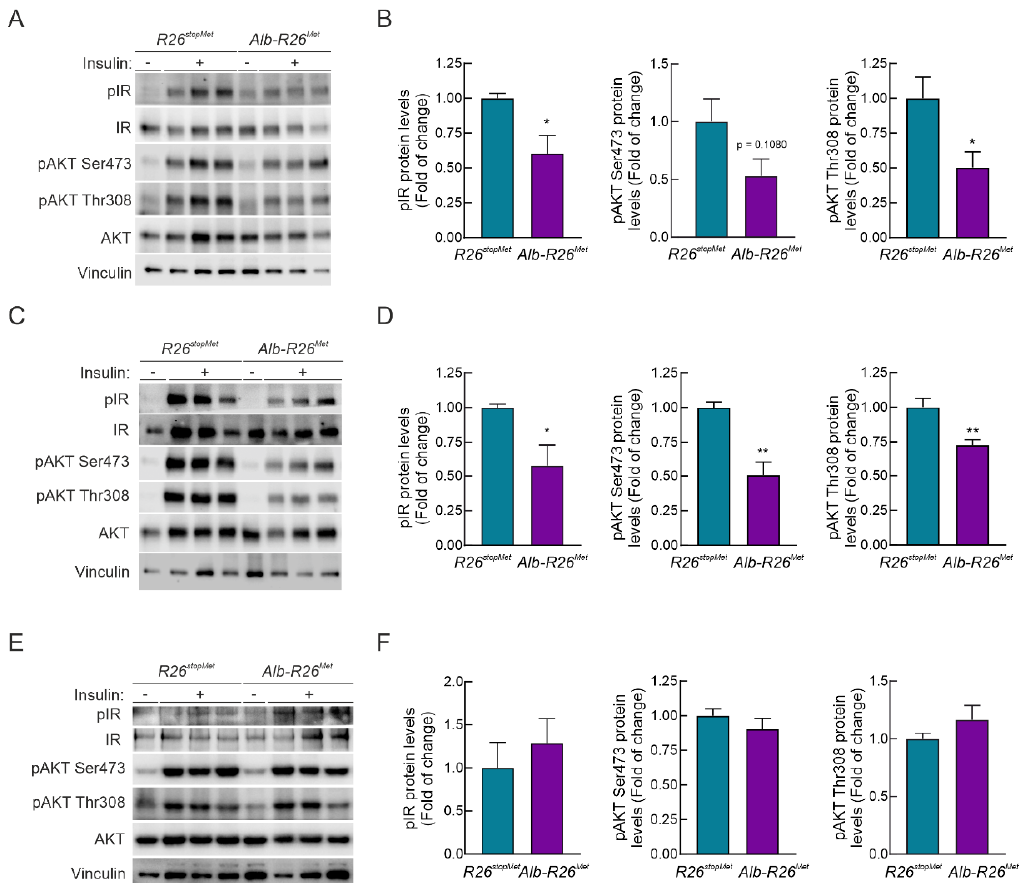
Figure 5. Hepatocyte enhanced MET levels lead to impaired insulin sensitivity in liver and in eWAT, but not in skeletal muscle. R26 stopMet and Alb-R26 Met mice were fasted 4 h and then submitted to insulin stimulation (i.p. injection, 0.75 U/Kg) for 15 min prior to sacrifice. Liver, epididymal white adipose tissue (eWAT) and skeletal muscle were collected. ( A ) Phosphorylation levels of IR and AKT (pIR and pAKT) in liver extracts from R26 stopMet and Alb-R26 Met mice ( n = 6 and 9 mice per group, respectively). IR, AKT, and Vinculin were used as loading controls. ( B ) Densitometric quantification of the indicated protein levels shown in ( A ). ( C ) Phosphorylation levels of IR and AKT (pIR and pAKT) in eWAT extracts from R26 stopMet and Alb-R26 Met mice ( n = 3 and 5 mice per group, respectively). IR, AKT, and Vinculin were used as loading controls. ( D ) Densitometric quantification of the indicated protein levels shown in ( C ). ( E ) IR ( n = 3 mice per group) and AKT ( n = 6 and 10 mice per group, respectively) phosphorylation levels in skeletal muscle extracts from R26 stopMet and Alb-R26 Met mice. AKT, IR, and Vinculin were used as loading controls. ( F ) Densitometric quantification of the indicated protein levels shown in ( E ); ( B , D , F ) Values are mean ± SEM. Statistical analysis was performed according to Student’s t test. * p < 0.05, ** p < 0.01 vs. R26 stopMet